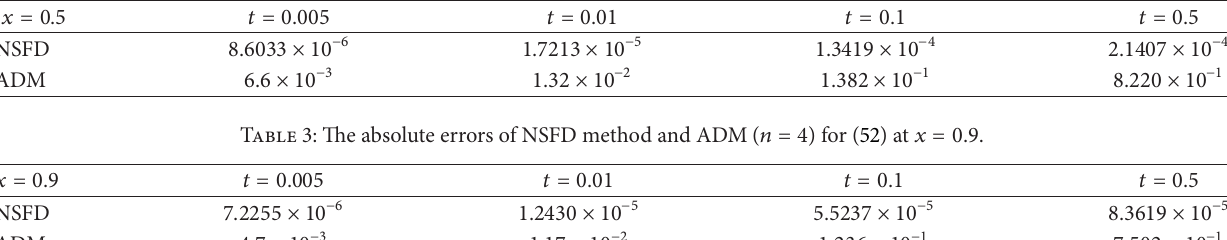
Table 2: The absolute errors of NSFD method and ADM (𝑛 = 4) for (52) at 𝑥 = 0.5 . 𝑥 = 0.5